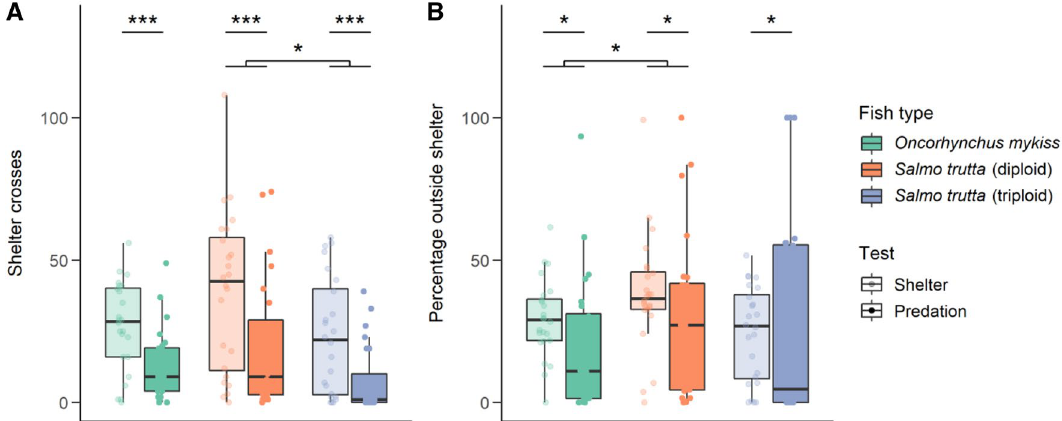
Figure 3. Boxplots showing the variables measured during the shelter and predation tests, with median and interquartile range plotted and overlayed with raw data points. Asterisks show significance values (* p < 0.05,